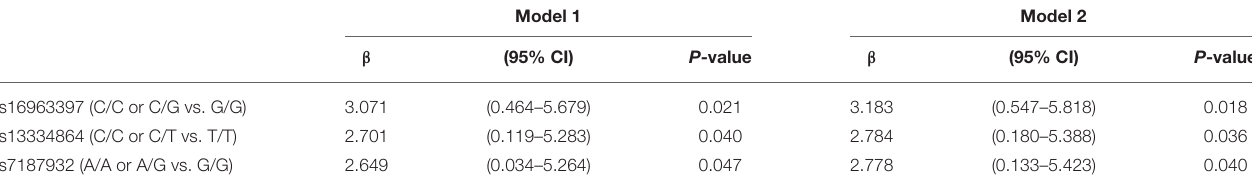
TABLE 3 | Multivariate analysis for estimated glomerular filtration rate (cohort